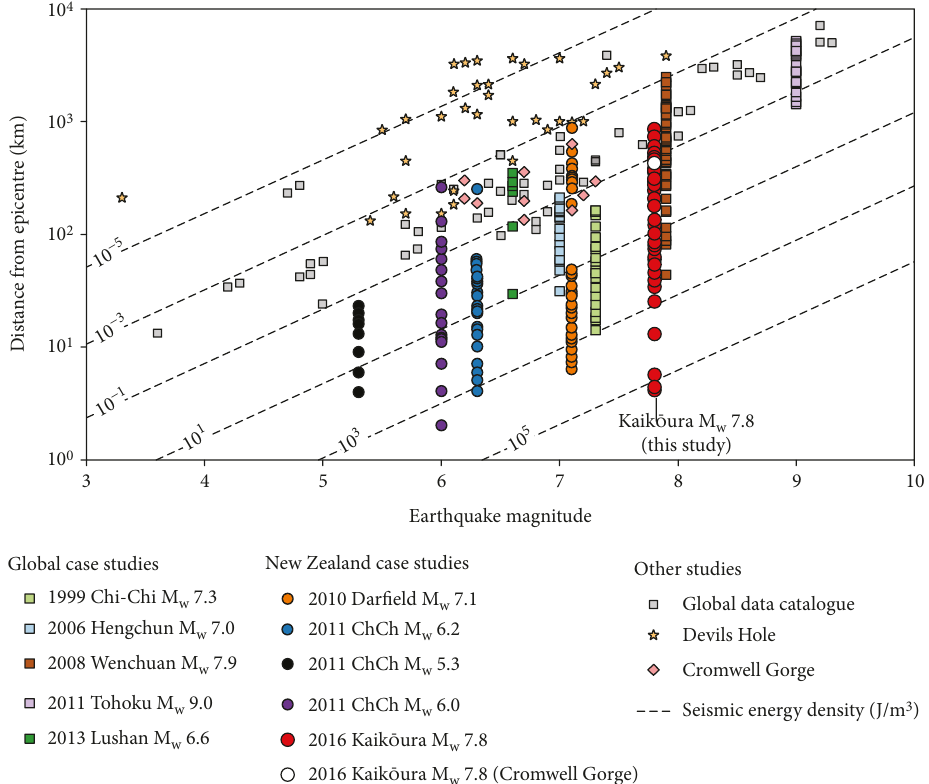
Figure 3: Earthquake magnitude as a function of distance from epicentre, where a groundwater level response was observed. We collated New Zealand and global case studies. New Zealand studies include 2010 Dar fi eld M 7.1 [23]; 2011 Christchurch M 6.2, 5.3, 6.0 [104]; and w w 7.3 and 2006 Hengchun M 7.0 [82]; 2008 Wenchuan M 7.9 [37, Cromwell Gorge [34]. International studies include 1999 Chi-Chi M w w w 105]; 2011 Tohoku M 9.0 [106]; and 2013 Lushan M 6.6 [33]. Also included is a worldwide compilation of groundwater responses [84], w w responses from the extremely sensitive Devils Hole [75], and seismic energy density contours in J/m 3 [40].